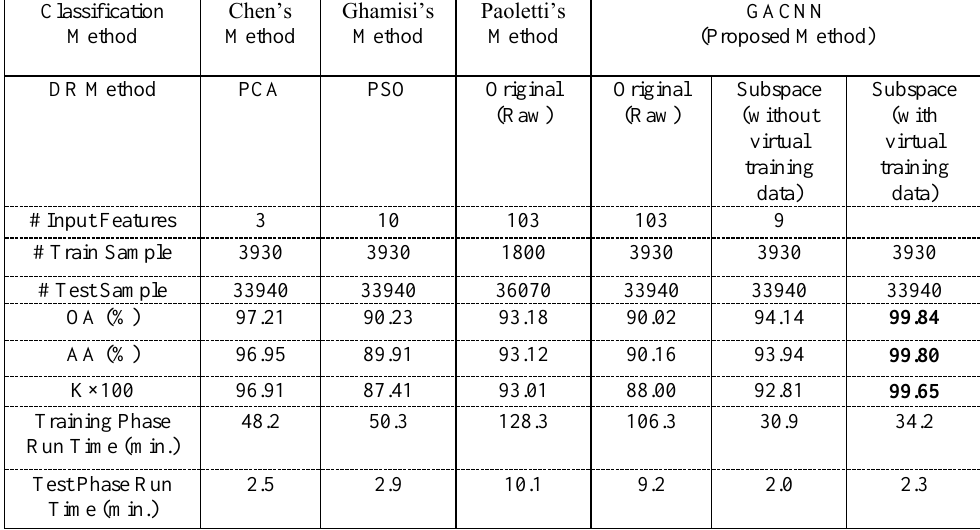
Table 4.Classification results on the Indian Pine dataset